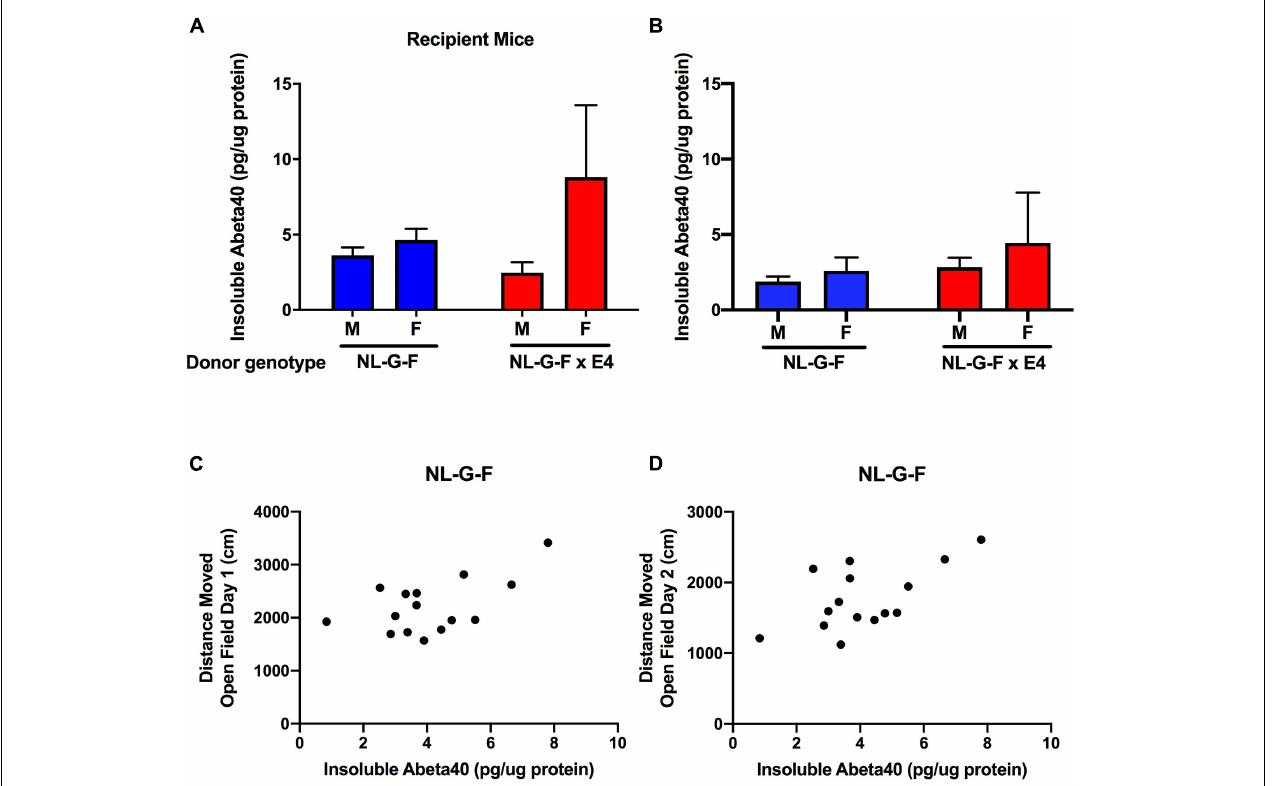
FIGURE 5 | (A) Insoluble cortical A β 40 levels in App NL − G − F and App NL − G − F / E4 recipient mice. (B) Insoluble cortical A β 40 levels in App NL − G − F and App NL − G − F / E4 donor mice. (C) In App NL − G − F recipient mice, cortical insoluble A β 40 levels were positively correlated with activity levels on the first day of open field testing ( r = 0.5629, p = 0.028, 15 data points, Pearson correlation). (D) In App NL − G − F recipient mice, cortical insoluble A β 40 levels also were positively correlated with activity levels on the second day of open field testing ( r = 0.5949, p = 0.0193, 15 data points, Pearson